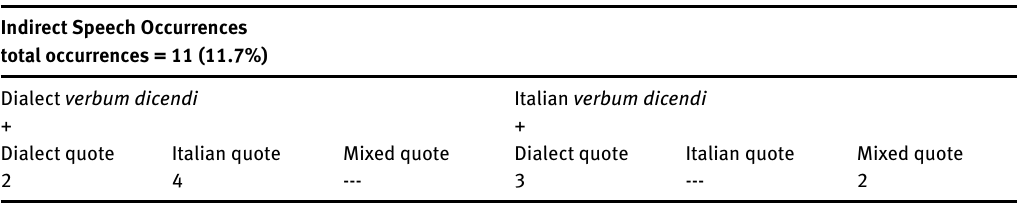
Table 4: Breakdown of IS